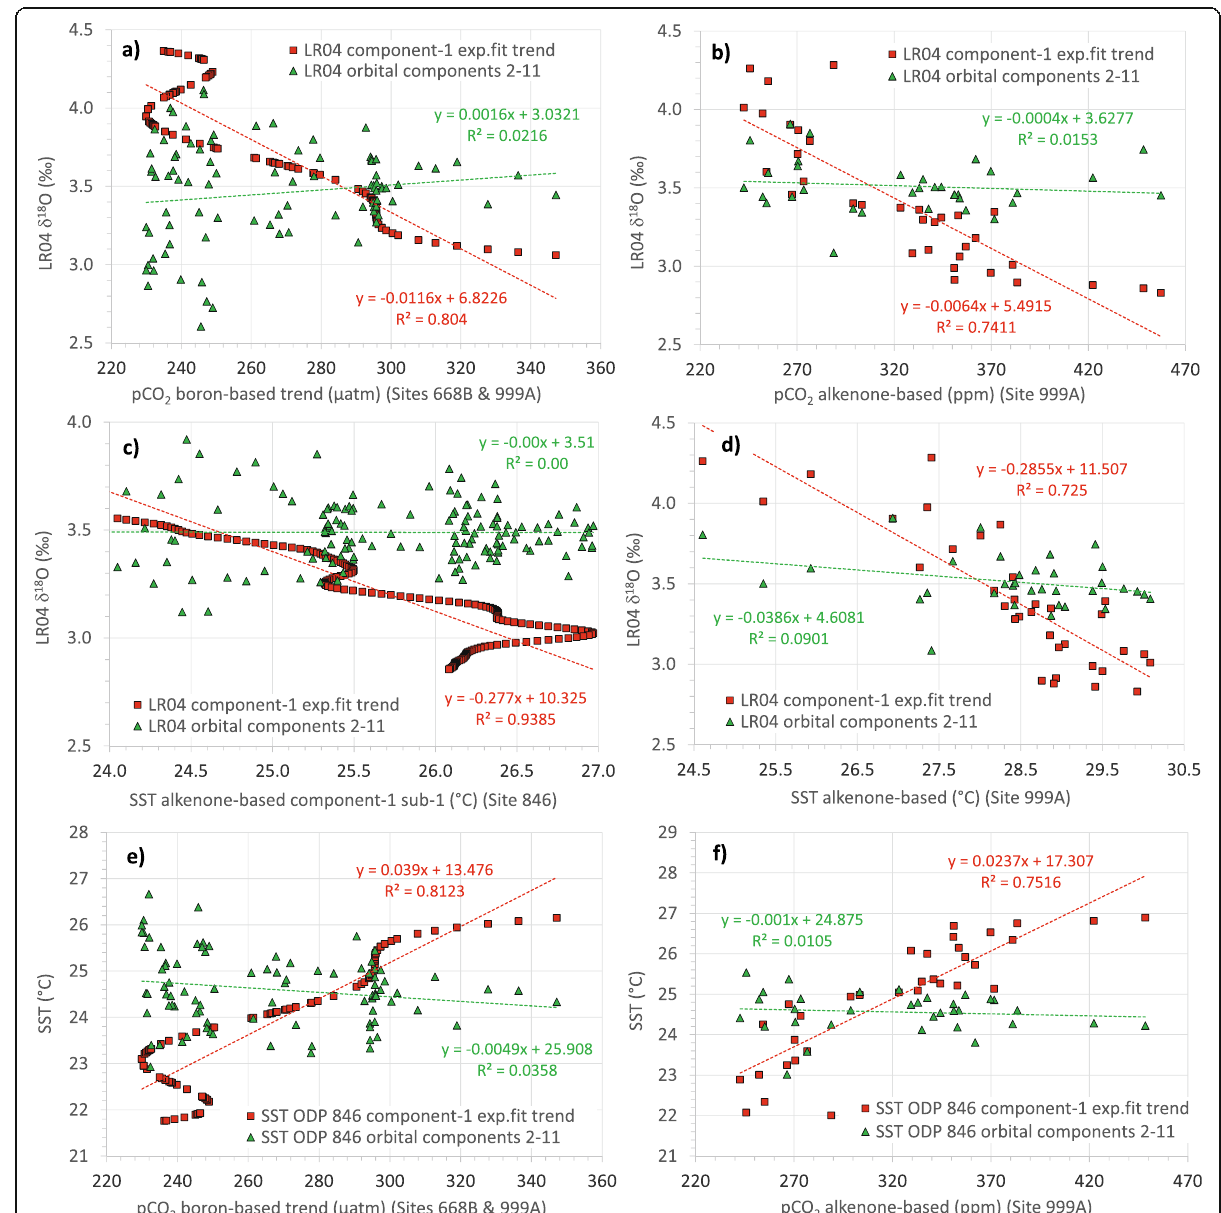
Fig. 12 Plio-Pleistocene cross plots between selected pCO 2 proxies and the δ 18 O ( a , b ) and SST ( e , f ) SSA-components. Plio-Pleistocene cross plots between selected SST proxies and the δ 18 O ( c , d ) SSA-components. A clear linear interpolation is shown between long-term trend components, whereas orbital components-2-11 are unrelated to the long-term trends. Proxy data: composite atmospheric boron-based pCO 2 proxy from ODP Sites 668B-999A (Hönisch et al. 2009; Bartoli et al. 2011), atmospheric alkenone-based pCO 2 and SST proxies from ODP Site 999A (Seki et al. 2010), alkenone- based SST proxy from ODP Site 846 (Herbert et al. 2010b), and LR04 δ 18 O stack (Lisiecki and Raymo